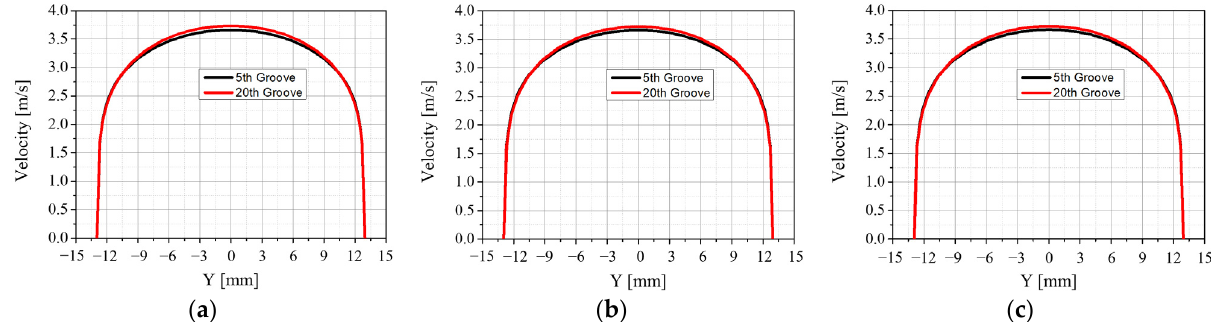
Figure 16. Main flow velocity profile at groove end for different p / k . ( a ) Main flow velocity profile at the groove end for p / k